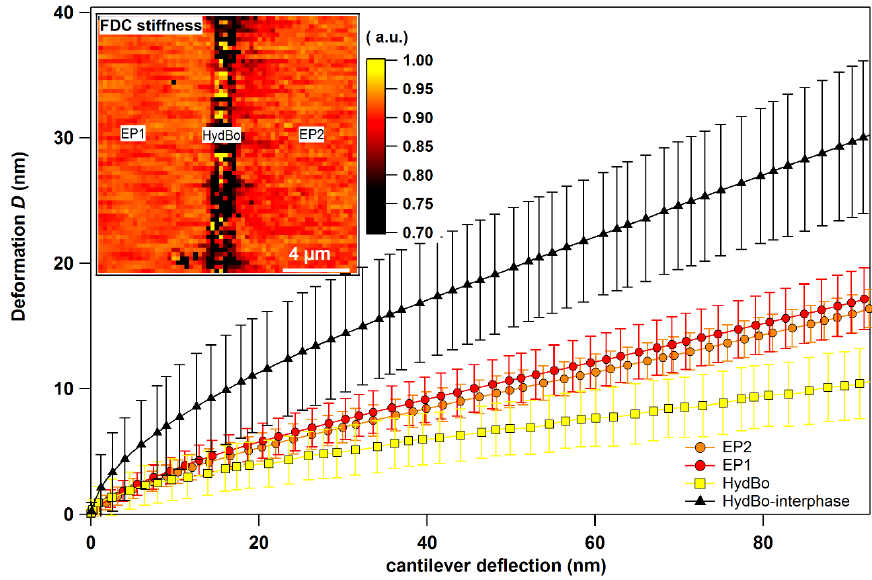
Figure A4. Force distance curves (FDC) sti ff ness map (inset image) and average force-distance curves Figure C1. Force distance curves (FDC) stiffness map (inset image) and average force-distance curves of the cross-sectional surface of EP1 / HydBo / of the cross-sectional surface of EP1/HydBo/EP2.